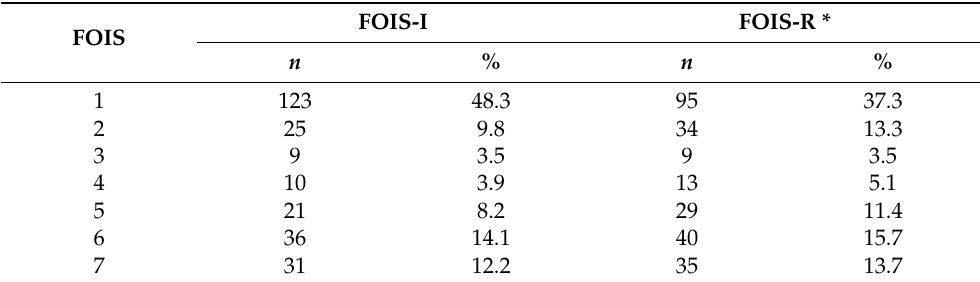
Table 1. Patient distribution of each FOIS score at the initial nutrition support team consultation (FOIS-I) and the recommended mode of nutritional intake (FOIS-R).